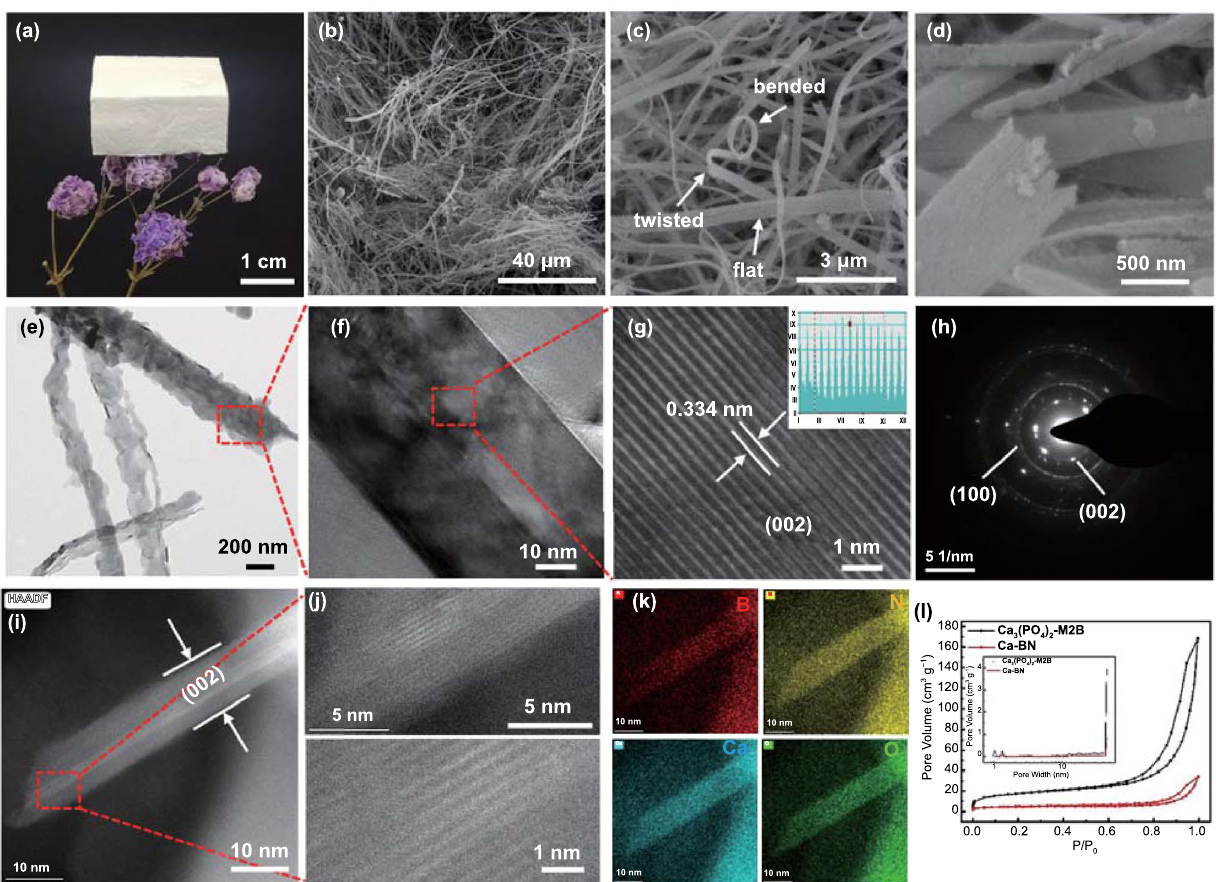
Fig. 1 a Optical image of Ca-BN aerogel. b – d SEM images of Ca-BN aerogel. e – f TEM images of Ca-BN aerogel. g – h HRTEM image and the corresponding electron diffraction pattern of Ca-BN aerogel. i – j STEM images of Ca-BN aerogel. k STEM-EDS mappings of Ca-BN aerogel. l Nitrogen adsorption–desorption isotherm curves of Ca-BN aerogel and Calcium phosphate-doped M·2B precursor. Inset in image l , the corre- sponding pore size distribution